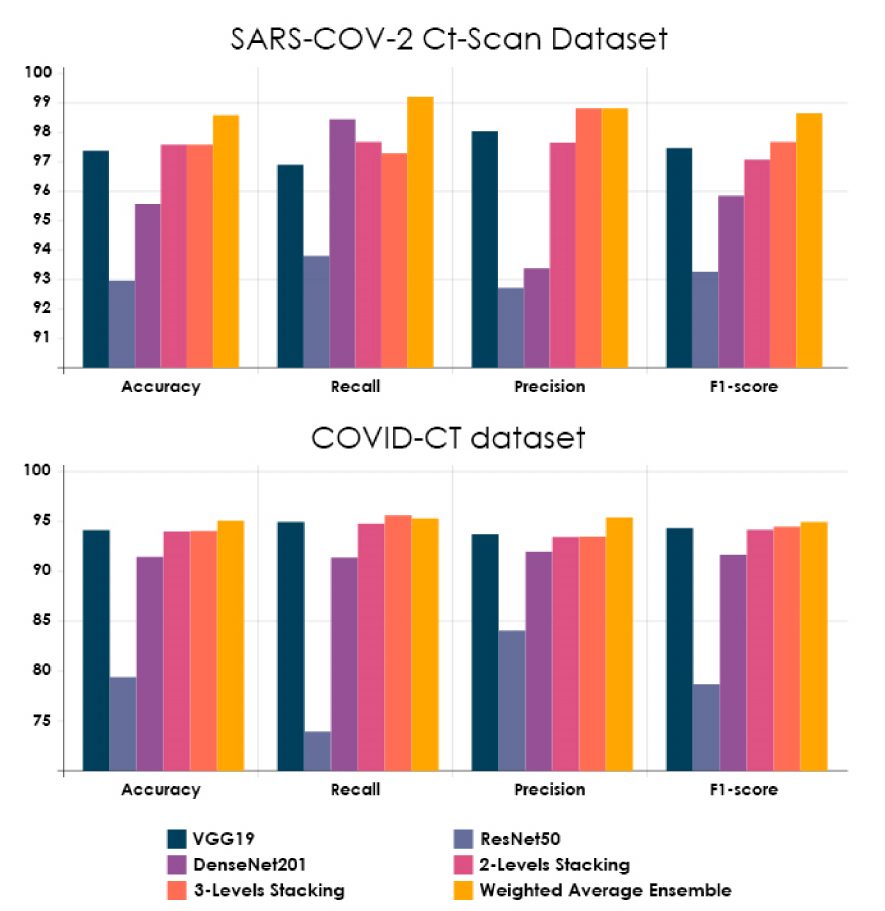
Figure 20. The performance evaluation metrics on both chest CT datasets for all studied